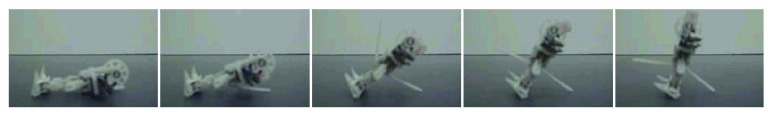
Self-righting process of a jumping robot designed by Zhao et al. [99].